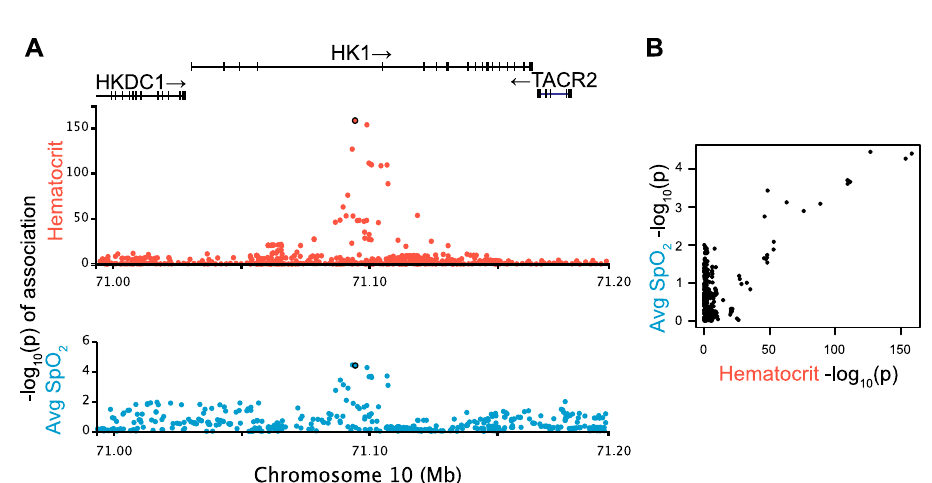
Fig 2. Pleiotropy at HK1 locus. A) Putatively pleiotropic locus linking a clinical trait (hematocrit) with an OSA trait (average SpO 2 ). The evidence of shared effect between the clinical and OSA traits is significant (JLIM p = 4.2 x 10 − 4 , FDR = 0.017). This SpO 2 association replicates in validation cohorts after Bonferroni correction of 61 tests ( p = 8.5 x 10 − 5 ). B) Pairwise comparison of–log 10 ( p -values) between two traits confirms that the association signals are driven by the shared underlying effect. Each dot represents a SNP in the tested locus.